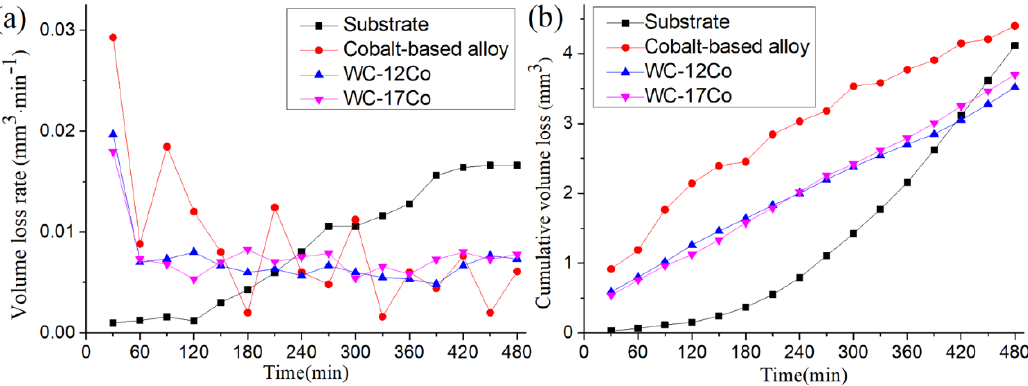
Figure 7. Volume loss of the coatings in deionized water: ( a ) volume loss rate and ( b ) cumulative volume loss.